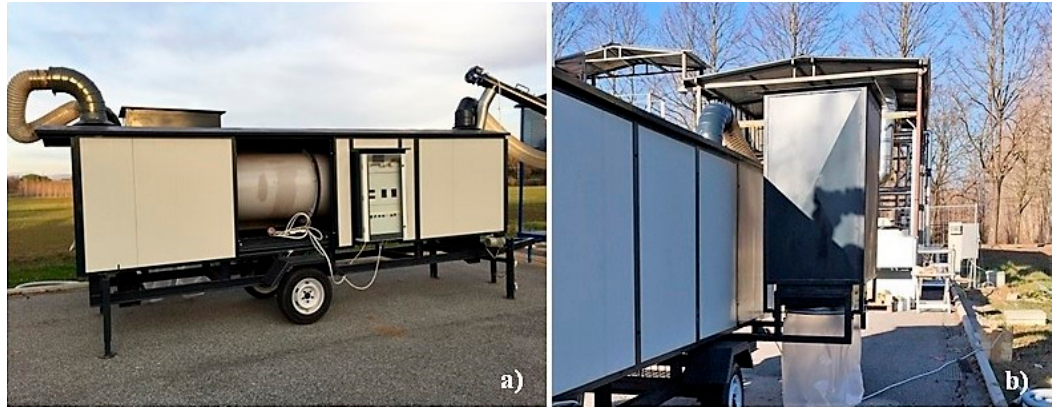
Figure 1. Rotary dryer prototype ( a ); dust recovery system ( b ).